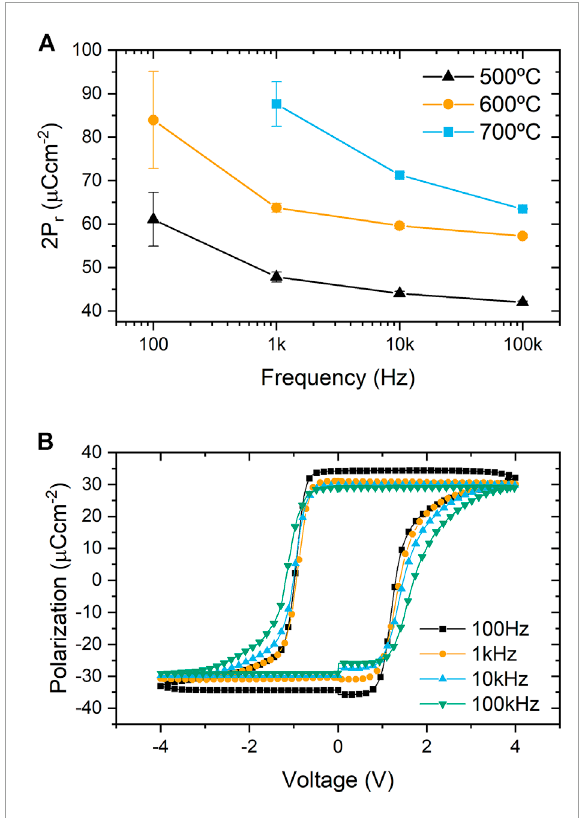
FIGURE 2 (A) Dependence of 2P r on the frequency of PUND scheme. (B) Polarization-voltage plots obtained using different frequencies of PUND scheme in HZO capacitors annealed at 600°C.